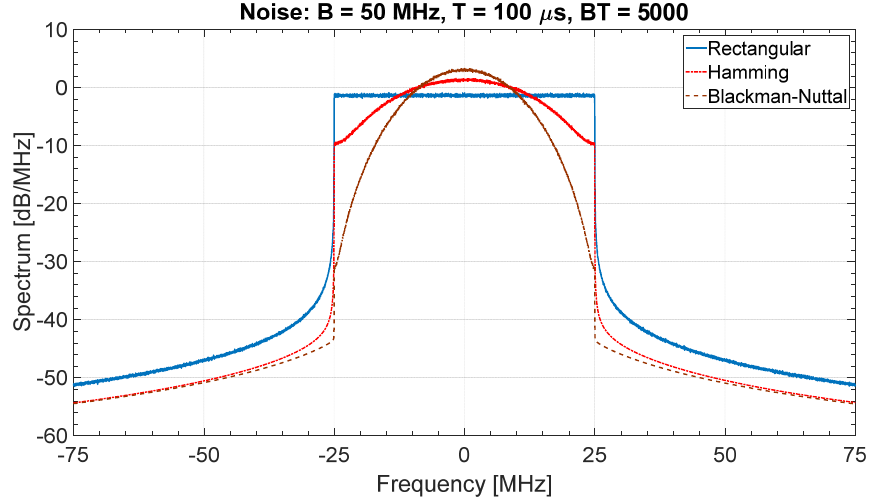
Figure 10. Shaped spectrum of a noise spectrum by Rectangular, Hamming, and Blackman-Nuttall